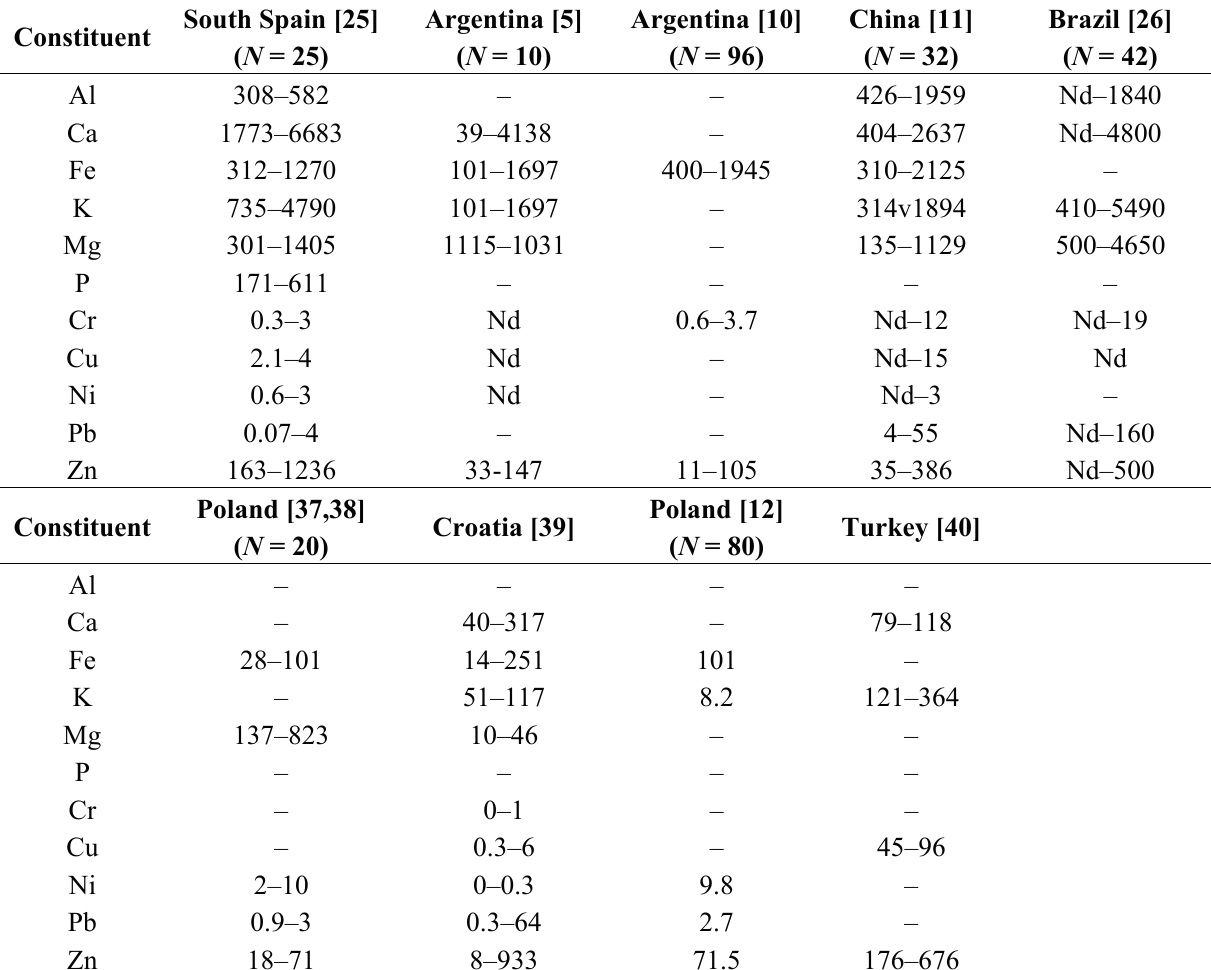
Table 2. Mineral composition of propolis samples of different geographic origin